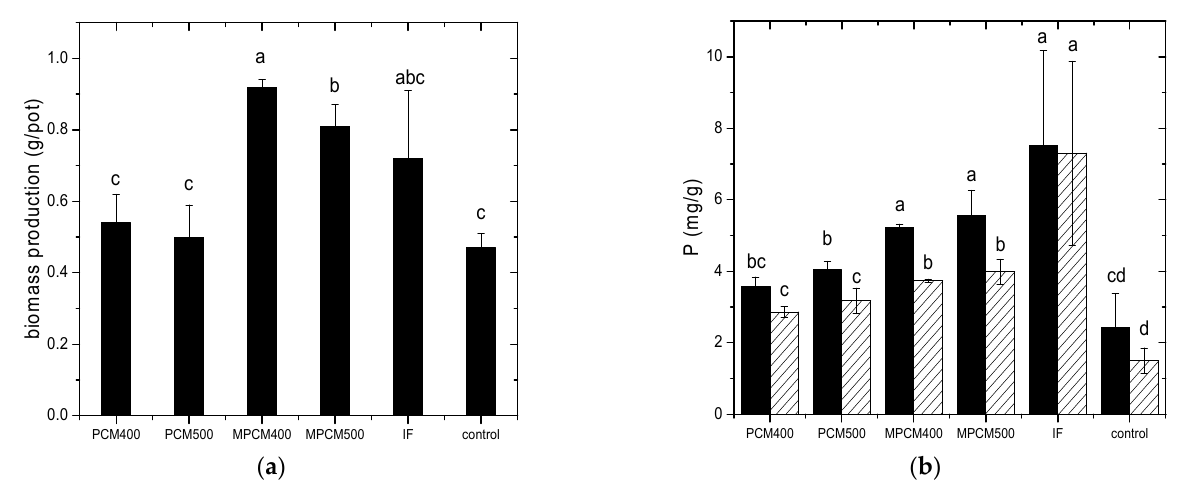
Figure 4. Biomass production ( a ) of rye (d.w.) and total concentrations of P ( b ) measured in rye tissues (solid fill) and roots (hatched fill) obtained from pots (mean ± SD) amended by PCM400, PCM500, MPCM400, MPCM500, inorganic fertilizer (IF) and non-amended soil (control). Conditions of digestion procedure: method HNO 3 + HClO 4 , digestion block—temperature program 80 °C/60 min, 120 °C/40 min, 160 °C/40 min, 180 °C/60min, 210 °C/60 min) diluted in 61–62% HNO 3 and quantification by ICP-MS. Different letters mean statistically significant difference ( p < 0.05).